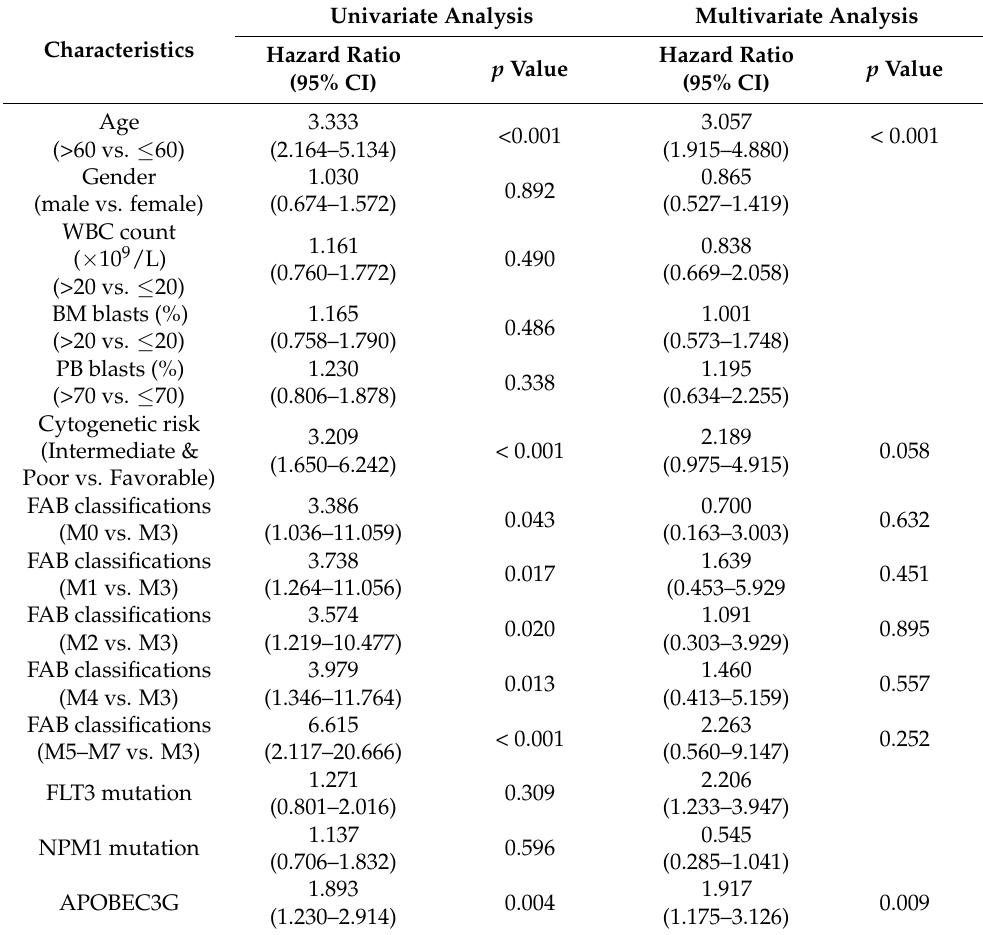
Table 2. Univariate and multivariate Cox’s regression analysis of factors associated with OS in